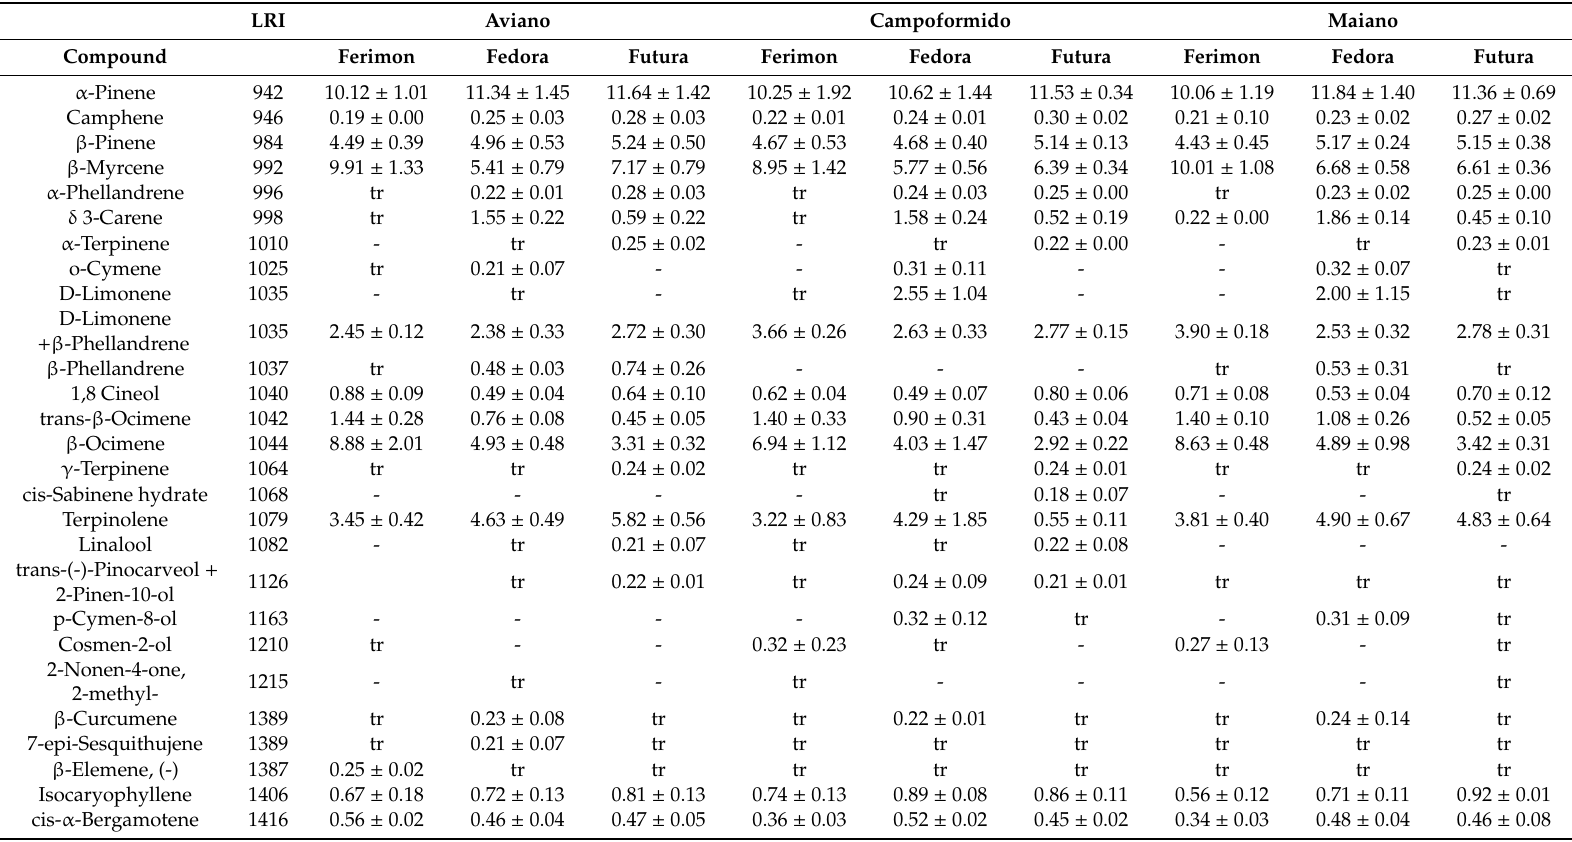
Table 4. GC–MS results of the essential oils extracted by hydrodistillation from the hemp inflorescences of the three monoecious varieties cultivated in Northern Italy. LRI Aviano Campoformido Maiano Compound Ferimon Fedora Futura Ferimon Fedora Futura Fedora Futura